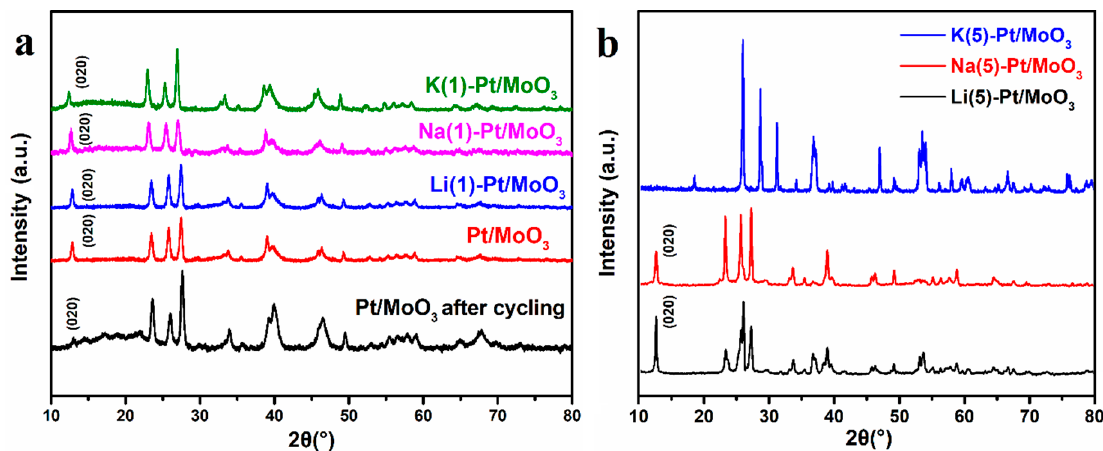
Figure 6. ( a )XRD patterns of Pt / MoO 3 after cycling, Pt / MoO 3 , Li(1)-Pt / MoO 3 , Na(1)-Pt / MoO 3, and K(1)-Pt / MoO 3 . ( b ) XRD patterns of Li(5)-Pt / MoO 3 , Na(5)-Pt / MoO 3 , and K(5)-Pt / MoO 3 .